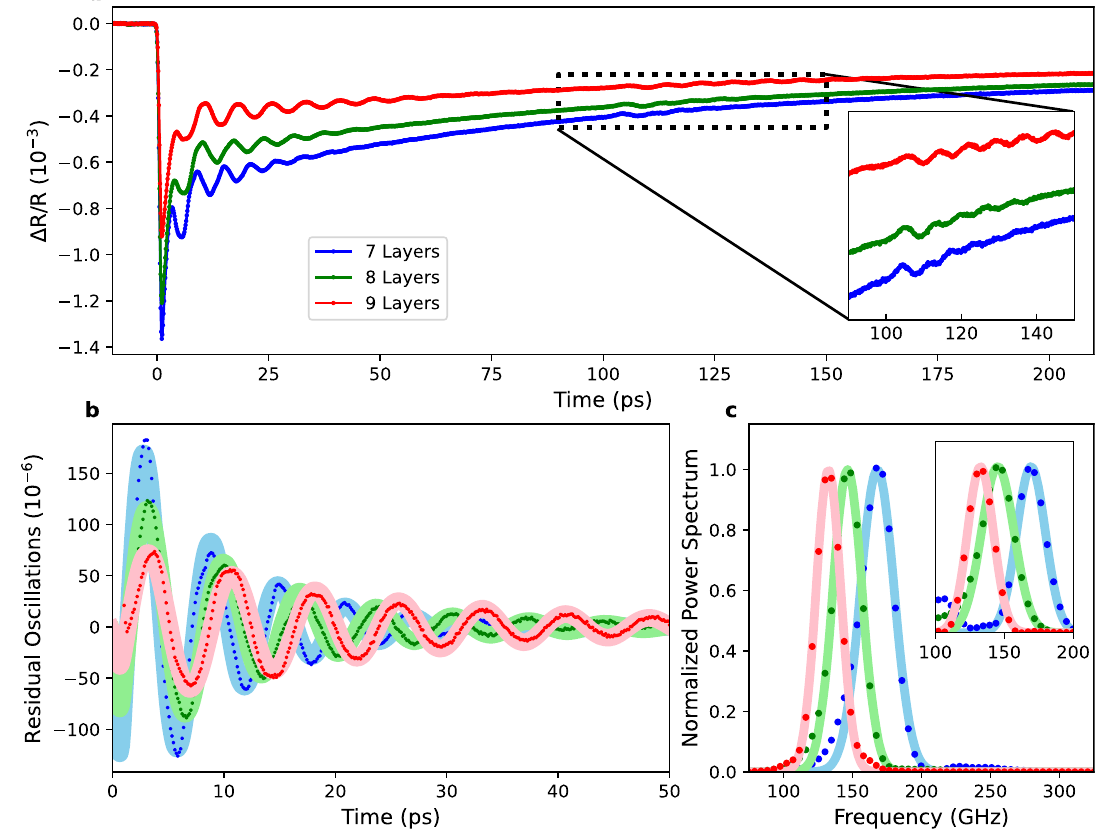
Fig. 2 Time-resolved re fl ectivity data measured at various thicknesses of exfoliated MnBi 2 Te 4 . The raw data ( a ) for three different regions shows the presence of a very short-lived spike, an exponential decay, and a phonon oscillation, with the inset highlighting an echo of the oscillation which occurs ~100 ps after the pump pulse. Subtracting the fi rst two components allows the phonon oscillation to be seen more clearly ( b ), where solid lines show fi ts to an exponentially decaying sinusoid, which match well aside from slight discrepancies at very short times (likely due to issues arising from subtraction of the very short-lived component). Plotting the data after FFT ( c ) highlights the clear shift in frequency between the different thicknesses. The inset in ( c ) shows the FFT of the echoes at ~100 ps, which have identical layer